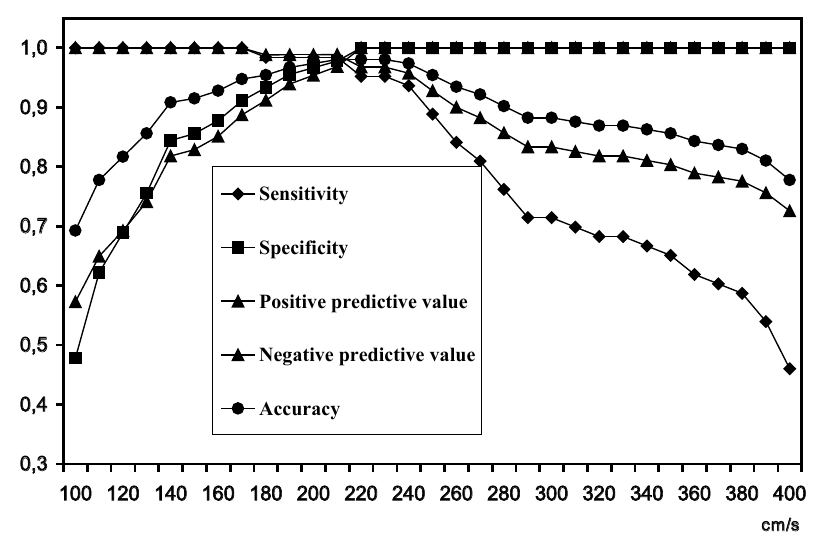
Fig. 1. Peak systolic velocity in the internal carotid artery.